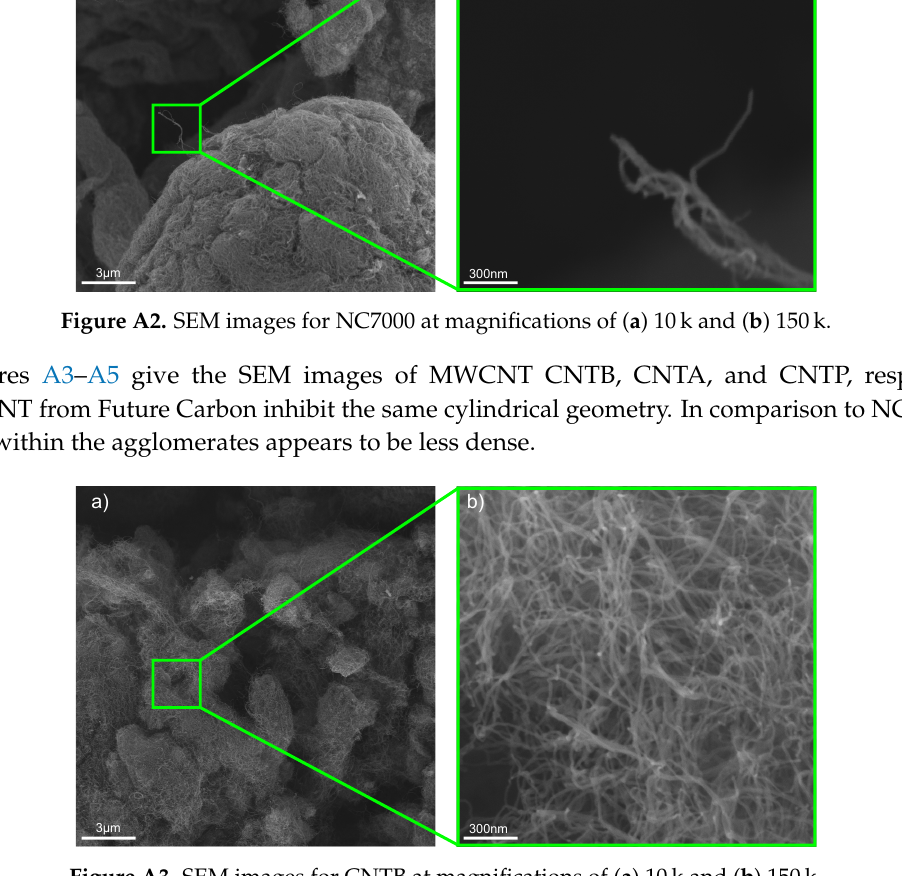
Figure A3. SEM images for CNTB at magnifications of ( a ) 10k and ( b )